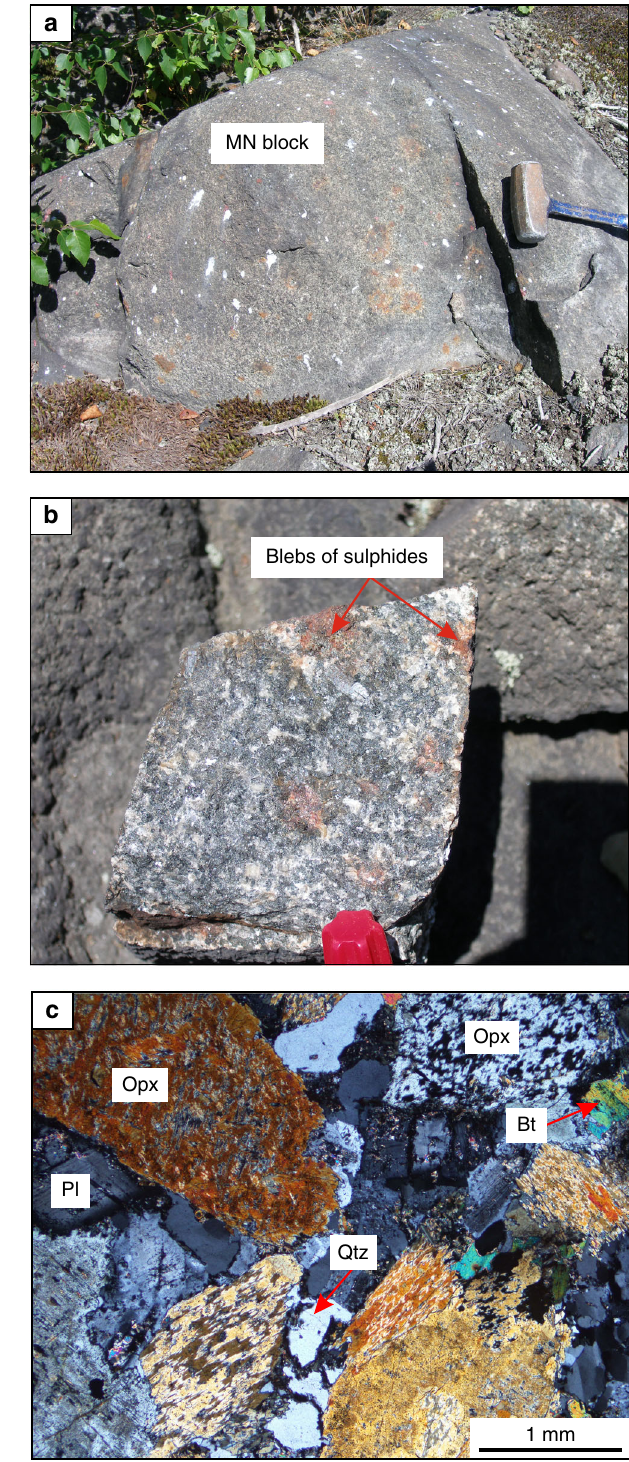
Fig. 3 Melanorite body hosted by felsic norite of the Creighton traverse in the South Range of the SIC. a Field photograph of an outcrop of melanorite body hosted by felsic norite. The length of the hammer head used for scale is 11 cm. b Blebs of sulphides on a weathered surface of melanorite.